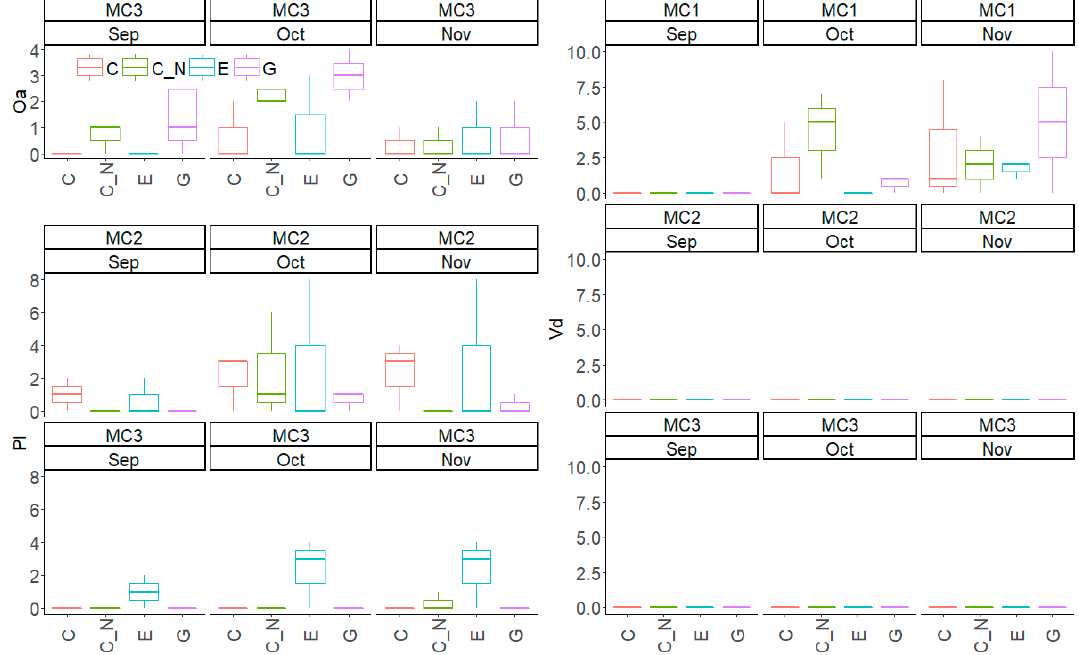
Hydrilla verticillata ; Pl = Potamogeton lucens ; Cc = Cabomba caroliniana ; Chara = Chara sp.